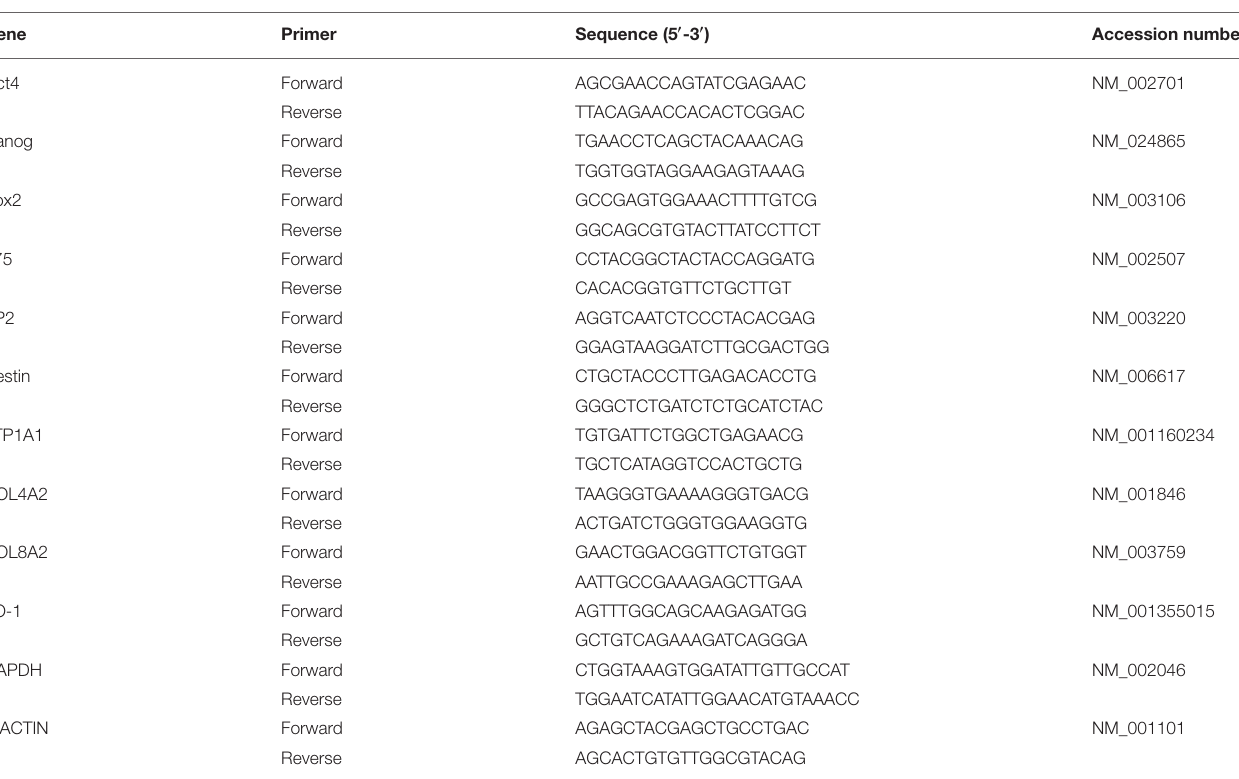
TABLE 1 | List of primers used for cDNA amplification in quantitative RT-PCR.